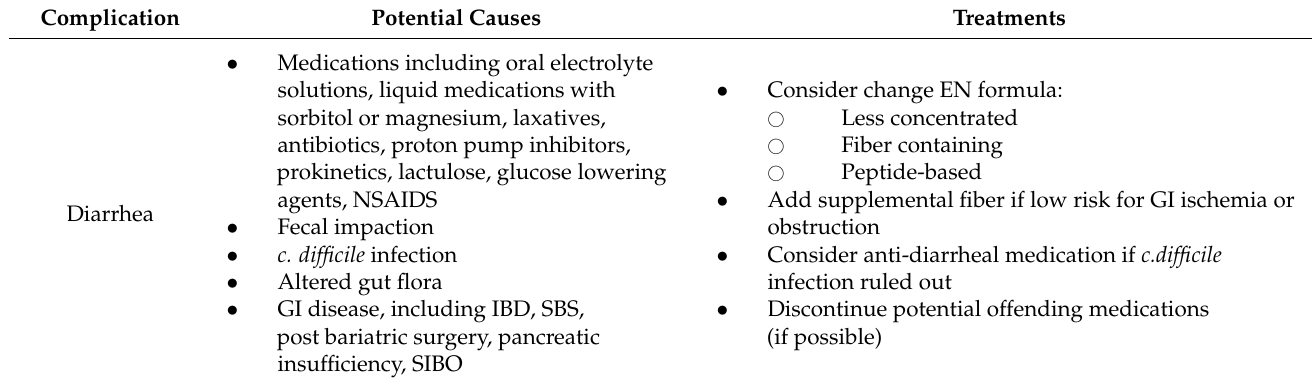
Table 3. Common causes and treatment for EN related complications